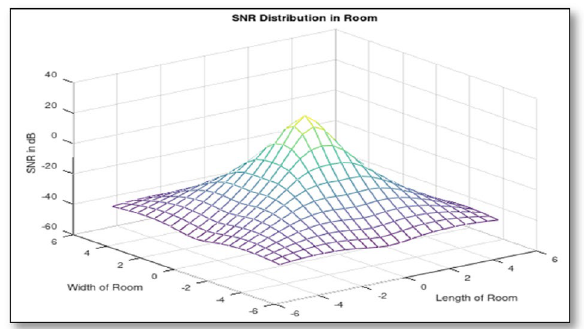
Fig. 3 SNR performance of a VLC